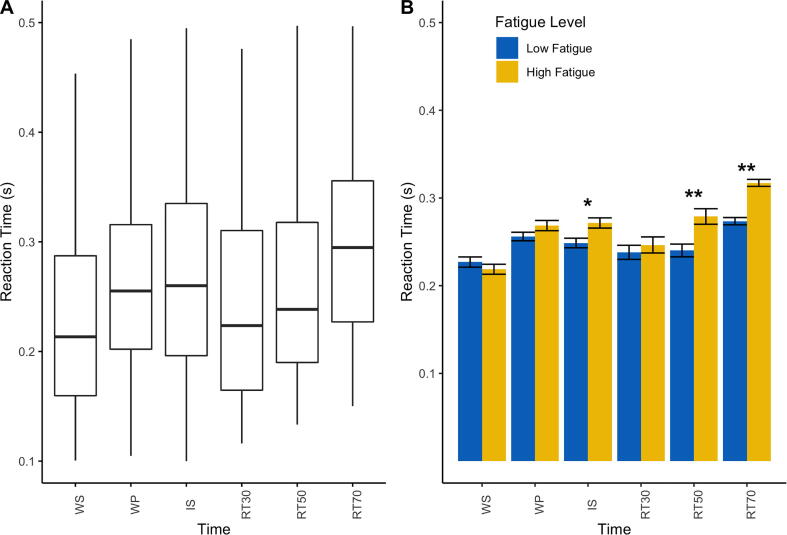
The effect of time and fatigue on reaction time (RT). A. Boxplot for RT across all stroke survivors for each time point indicating no significant effect of time on RT. B. Bar plots with standard error bars representing RT across all time points with stroke survivors grouped based on their fatigue score indicating the significant interaction between time and fatigue on RT. Fatigue was measured using the Fatigue Severity Scale (FSS-7). Low fatigue patients (FSS-7 < 4) are represented in blue and high fatigue patients (FSS > 4) are represented in yellow. The association between fatigue (FSS-7) and MEP amplitude for each time point is also shown. Significance levels are indicated by * (* < 0.05, ** < 0.001).